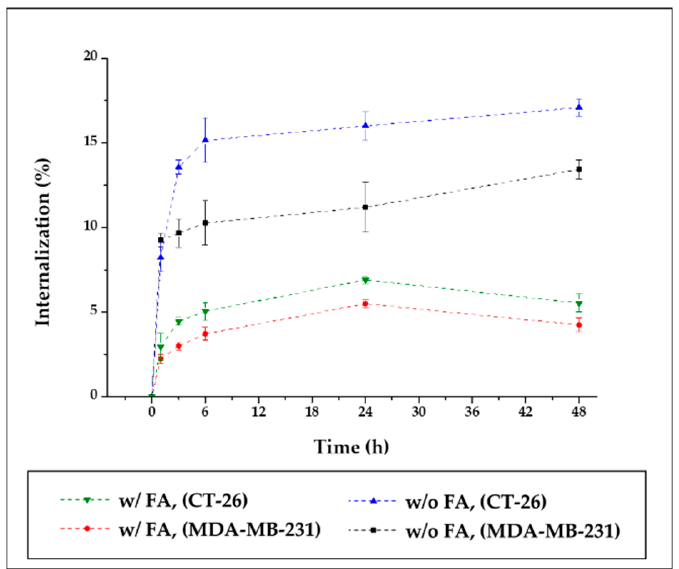
Figure 8. Cell internalization assay of 89 Zr-Fa-SMWs and 89 Zr-SMWs. Evaluation using folate receptor positive CT-26 (murine colorectal cancer cell) and MDA-MB-231 (human breast cancer cell) ( n = 3).